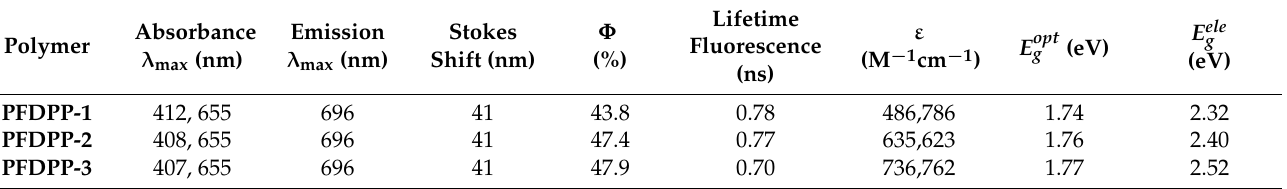
Table 4. Optical parameters of PFDPP polymers.